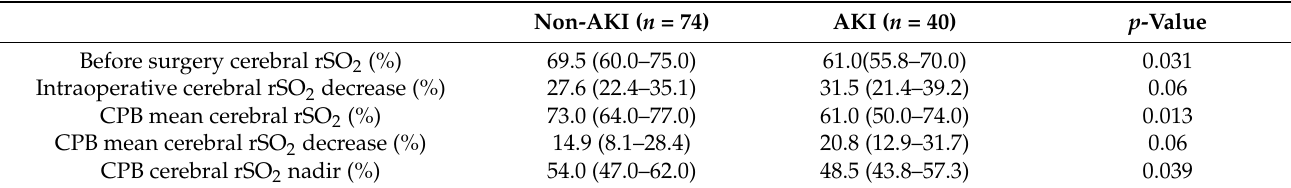
clinical outcomes 2